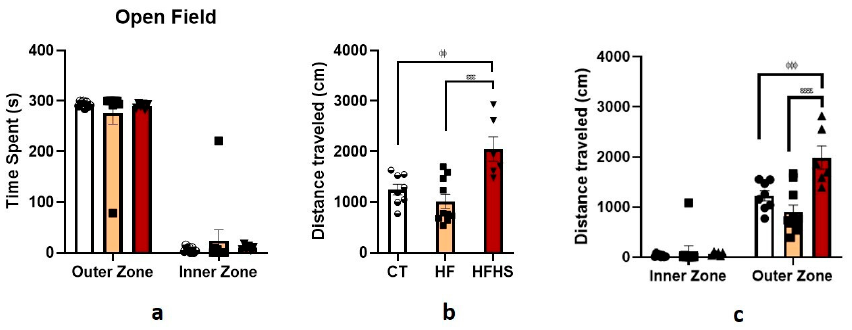
Figure 8. Open-field test. Histograms display the mean ± SEM time spent ( a ) in the outer and inner zones of the open field, the total distance traveled during all acquisitions ( b ), and the distance traveled in the outer and inner zones during the test ( c ). No differences were found among the three groups in the time spent in the inner and outer zones. For the total distance traveled, the HFHS animals traveled longer distances than the HF and control animals. For the distance traveled in the different zones of the apparatus, HFHS animals traveled long distances in the outer zone than HF and controlled animals; no differences were found for the inner zone. ϕϕ p < 0.01; ϕϕϕ p < 0.001 HFHS versus controls; εεε p < 0.001; εεεε p < 0.0001 HFHS versus HF. The bars in white represent the mean for the control group, the bars in orange represent the mean for the HF group, and the bars in red represent the mean for the HFHS group. The circle represents the value for each animal in the control group, the square represents the value for each animal in the HF group, and the inverted triangle represents the value for each animal in the HFHS group.